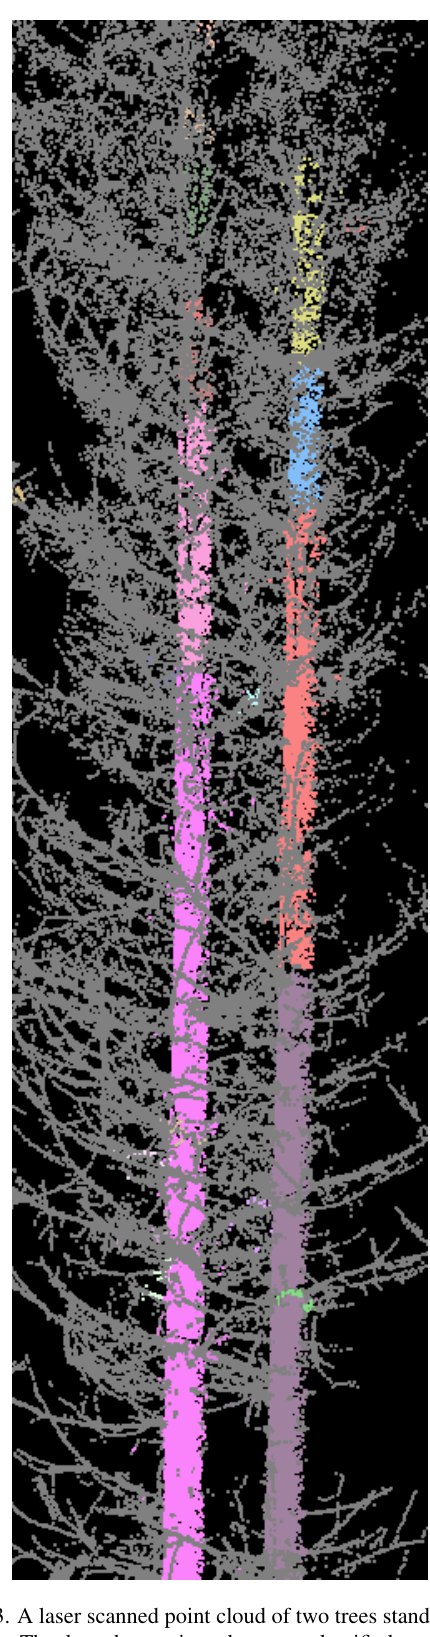
Figure 3. A laser scanned point cloud of two trees standing close together. The data observations that were classified as non stem points by the filter algorithm are coloured gray. The data points classified as stem points are used when cylinder fitting stem